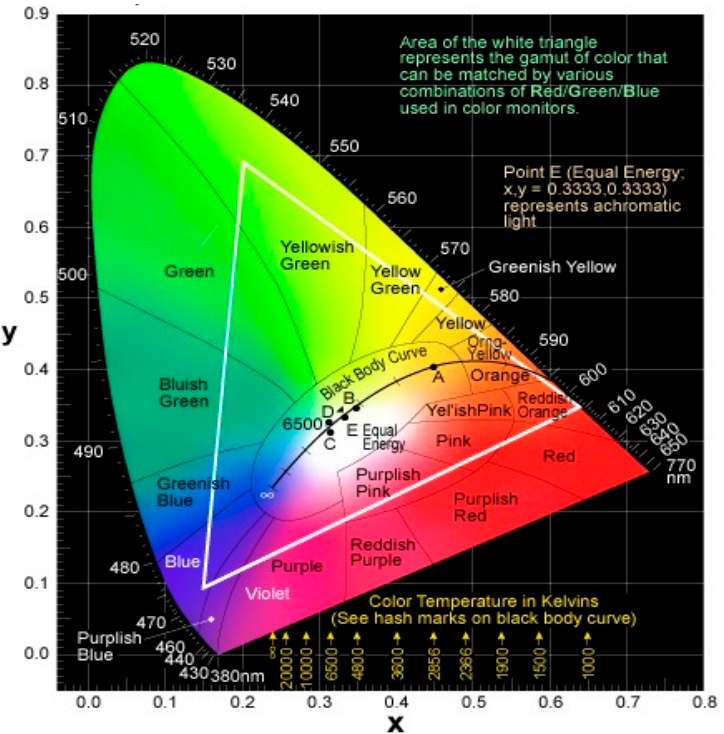
Figure 1. Diagram of the Commission International de L’Eclairage (CIE) chromaticity.